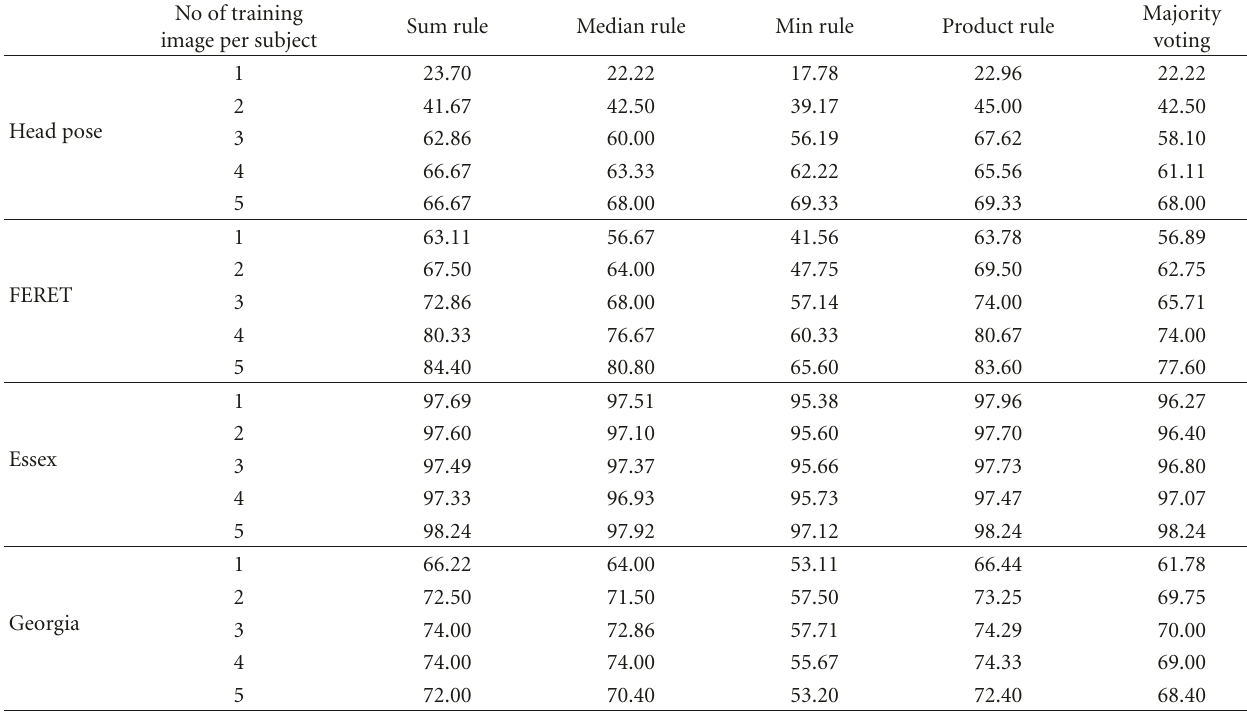
Table 5: Performance of di ff erent decision making techniques for the PCA-based face recognition system.